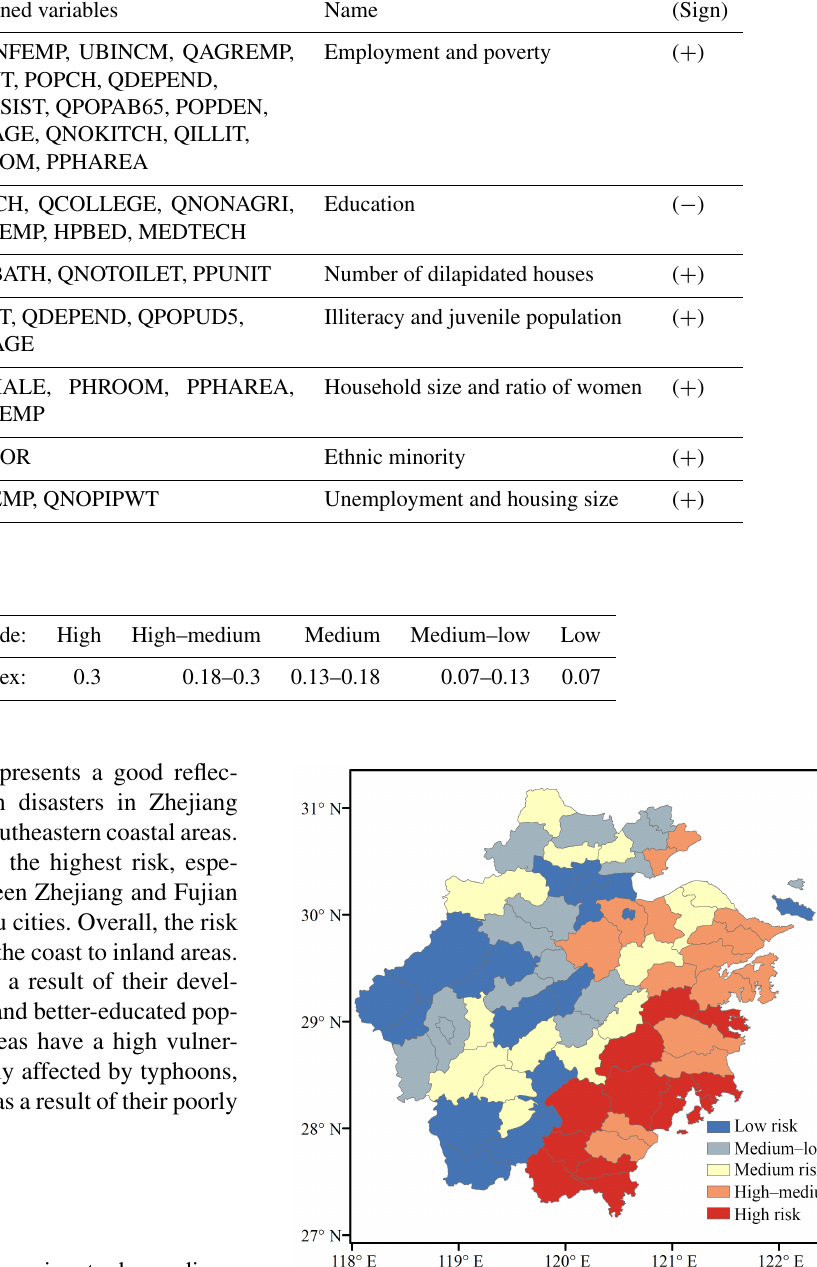
Table 3. The seven components extracted by PCA. Components